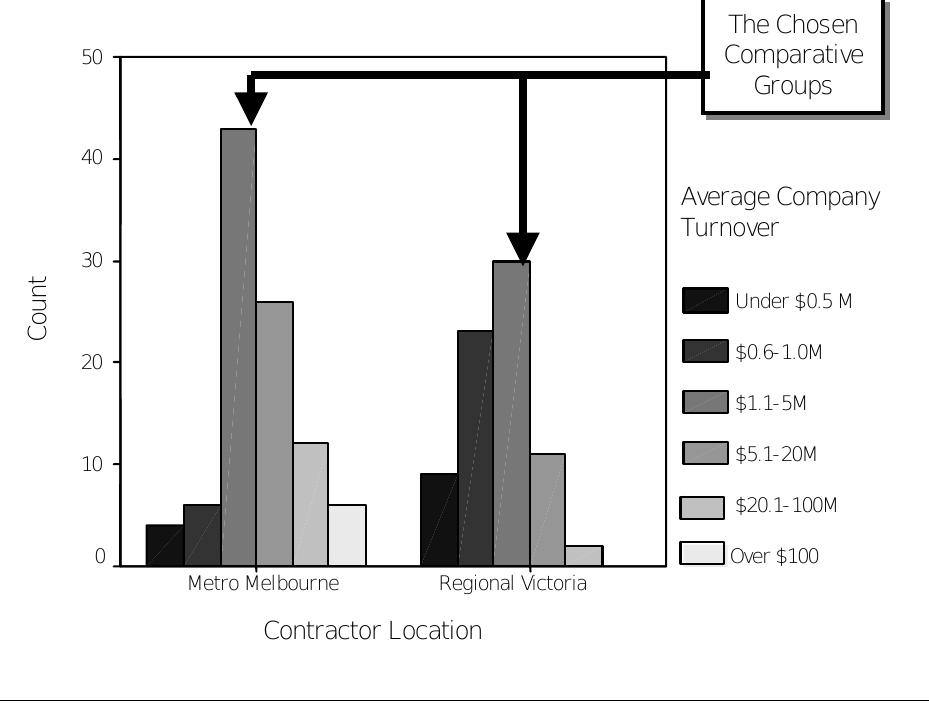
Figure 1: Size by average company turnover